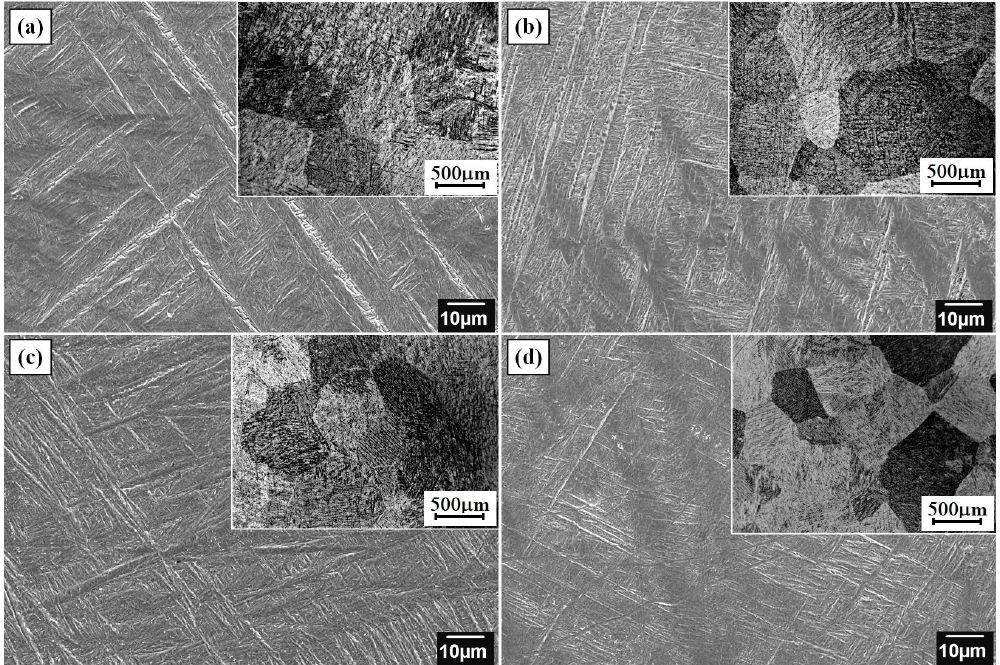
Figure 5. SEM micrographs of WQ samples: (a) Ti-15Nb, (b) Ti-15Nb-0.15Si, (c) Ti-15Nb-0.35Si, (d) Ti-15Nb-0.55Si. Inserts (a-d) present OM micrographs under lower magnifications.